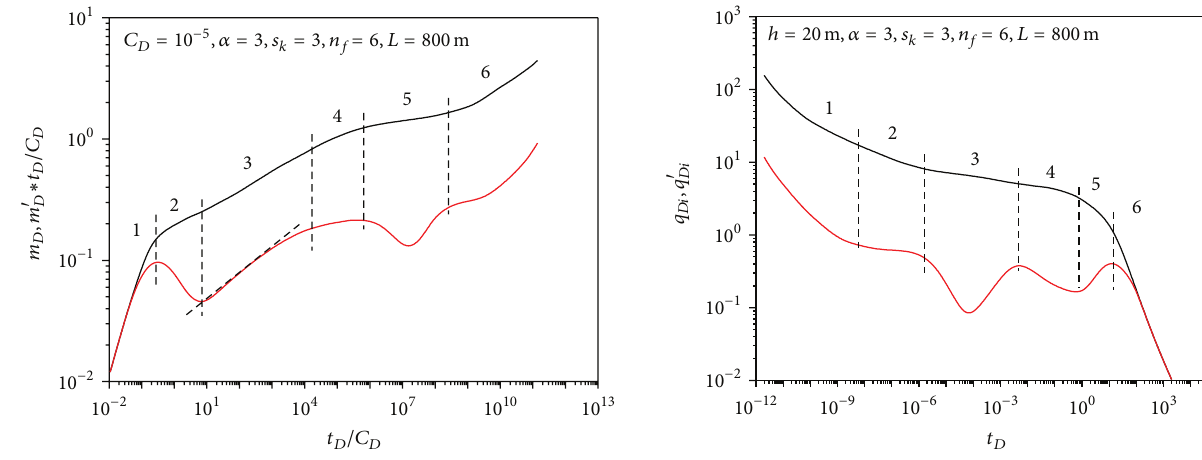
Figure 3: Type curve of pressure transient response for two-phase flow in multistage hydraulic fractured horizontal well in SGR.